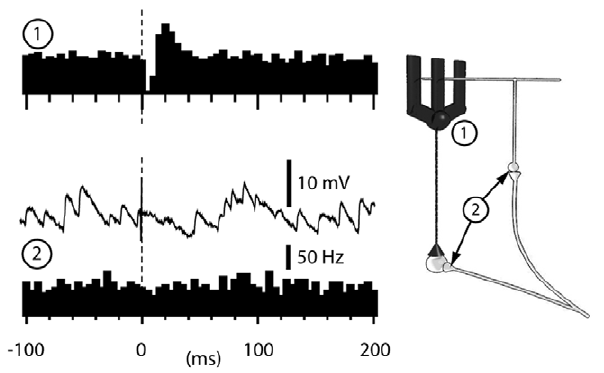
Figure 7. IO-evoked responses in cortical neurons. Simple spike responses of a PC (1) and MF-EPSP responses of a granule cell recorded in the whole cell mode (2) to IO stimulation. The granule cell data is shown both as a sample raw trace (recorded at 2 65 mV) and as a peristimulus histogram of EPSPs with IO-stimulation at 150 uA, which evoked substantial local climbing fiber field potentials in the cortex. widths in all histograms, 5 ms.